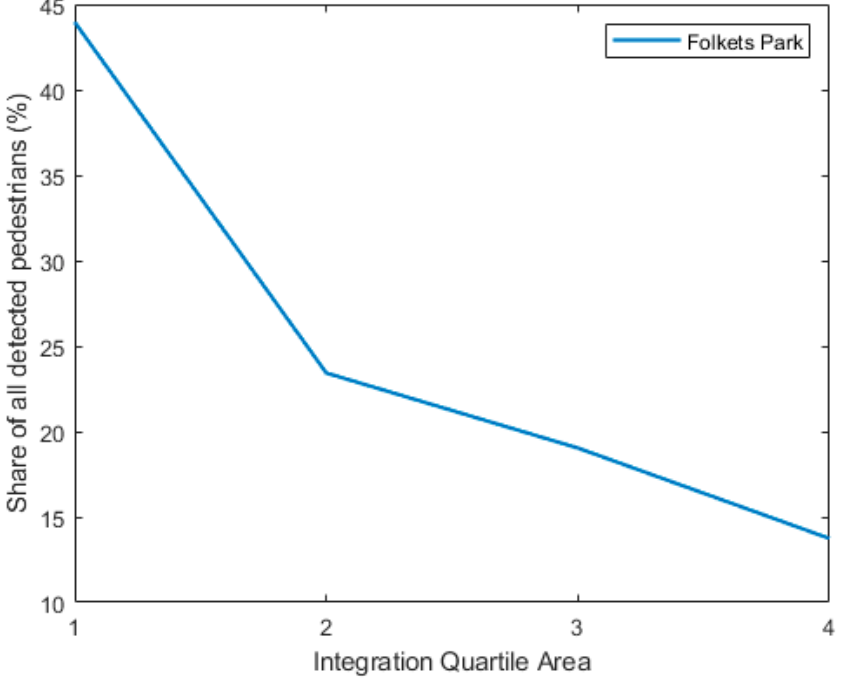
Figure 7. The relationship between integration level and the share of pedestrian detections at Folkets Park.